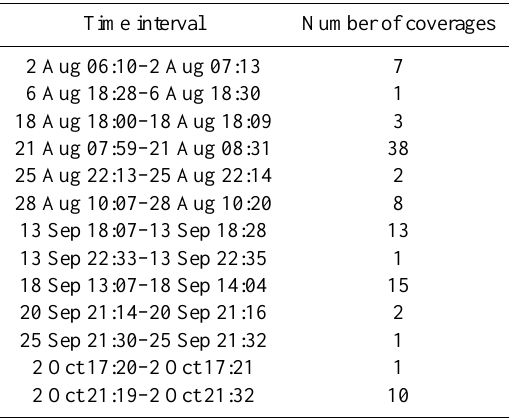
Table 1. Time intervals where current sheet coverages were ob- tained in 2002. Time